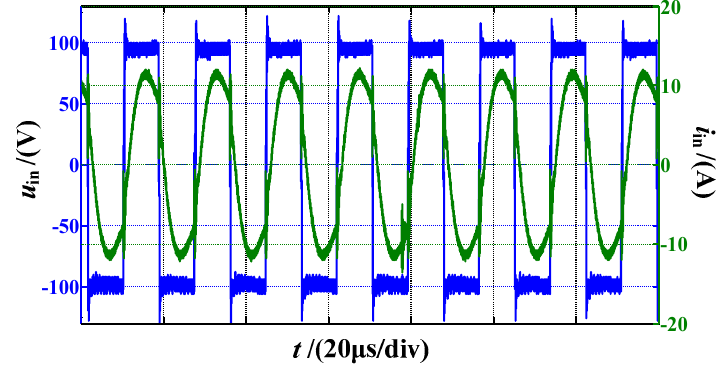
Figure 14. Output voltage( u in ) and current( i in ) of the inverter in constant power mode.